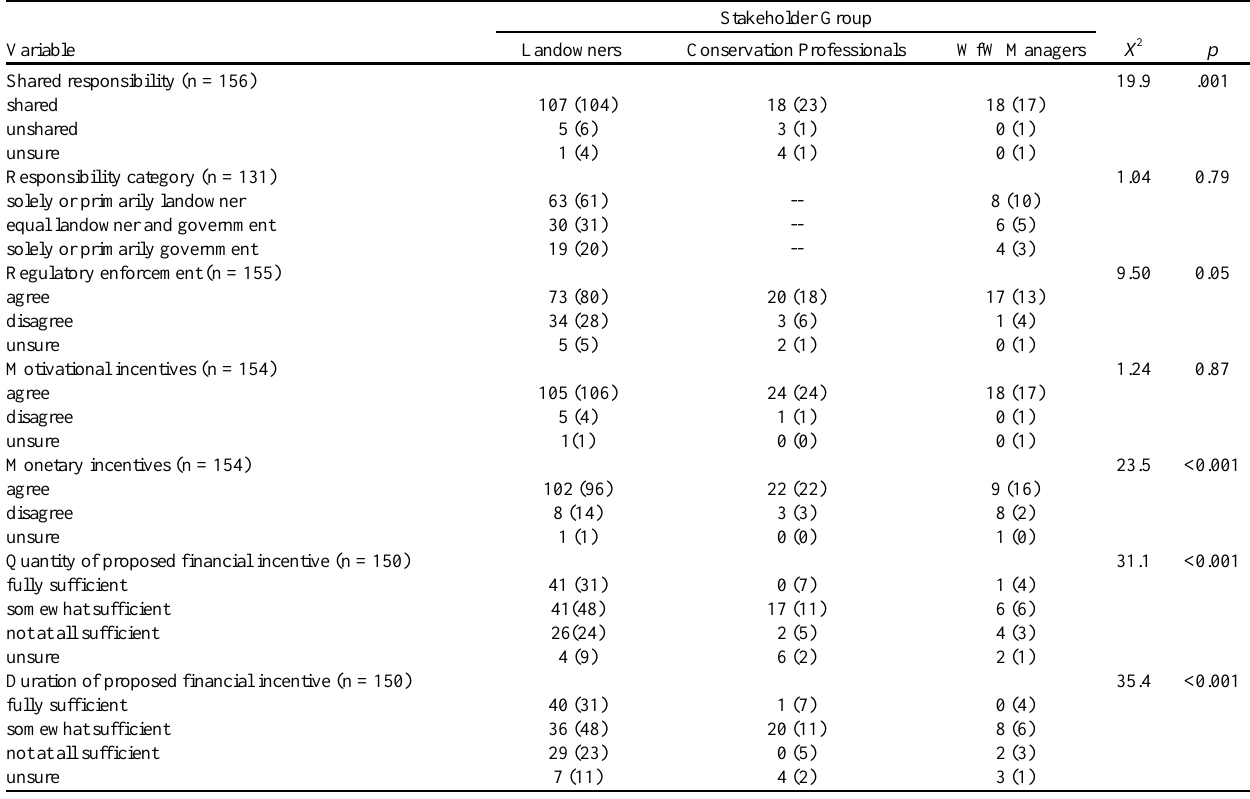
Table 4 . Relationships between stakeholder group and participant responses to closed-ended questionnaire items regarding the principles and structure of WfW’s proposed ecosystem service approach to clearing IAPs on private land, Western Cape. Values are the frequency observed (expected) based on chi-square